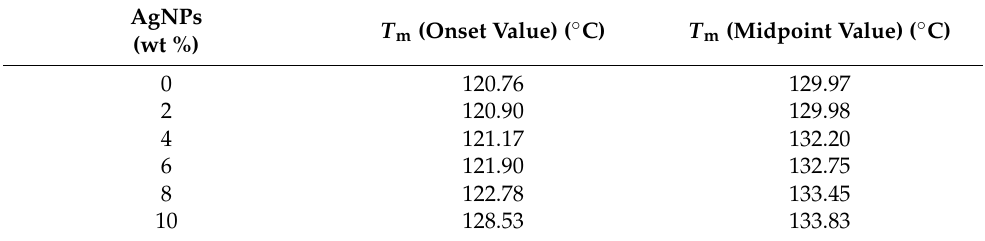
Figure 9. DSC thermograms of the kenaf/HDPE composites containing AgNPs. Table 2. Thermal properties of kenaf/HDPE composites without and with AgNPs, as measured from DSC thermograms.